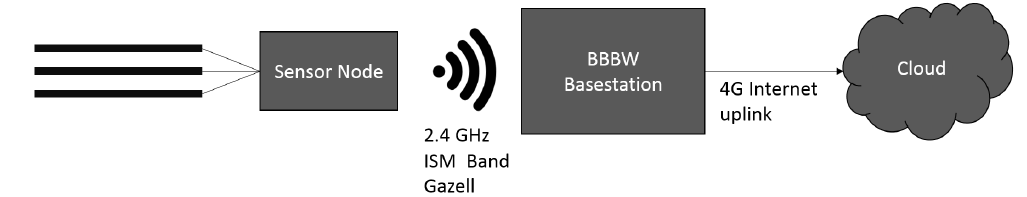
Figure 6. Diagram depicting the measurement